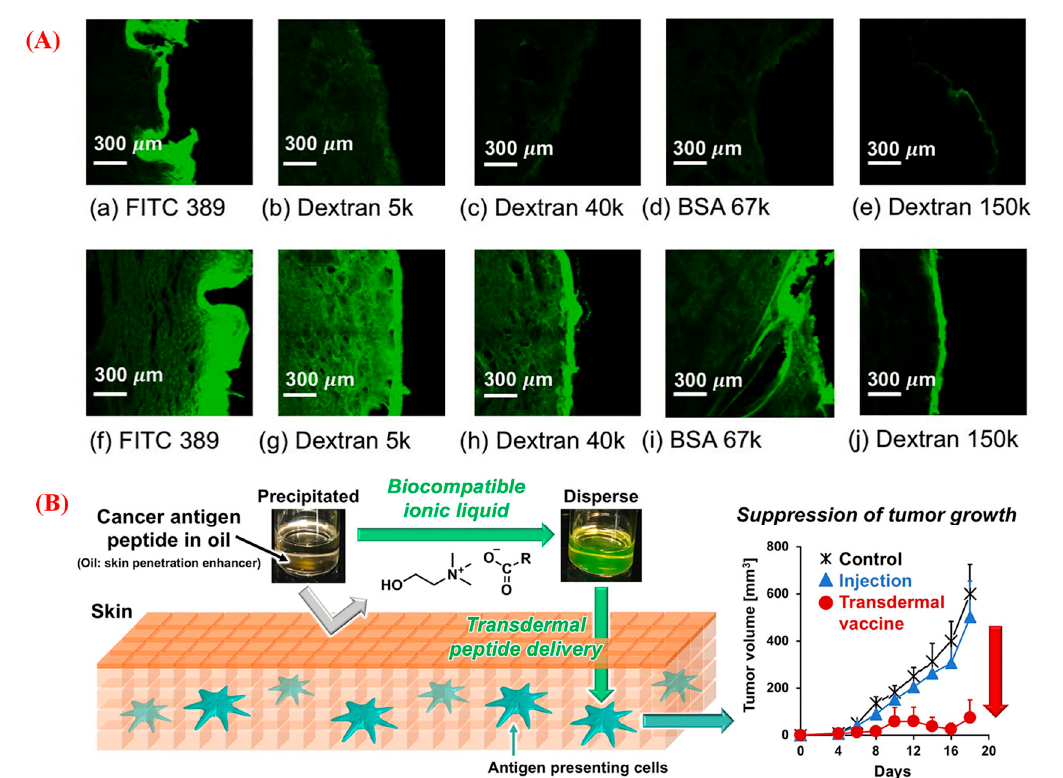
Figure 8. ( A ) Confocal microscopy showing the comparison of a variety of molecules solvated in PBS ( a – e ) and CAGE 1:2 ( f – j ) and transported through porcine skin. Fluorescence intensity was calibrated based on the stock solutions. FITC labelling was used except ( b , g ) which are TD [113], ( B ) IL-mediated micellar formulation enhancement of transdermal delivery of antigenic peptide using IL-in-oil microemulsion formulations [116]; reproduced with permission from refs.